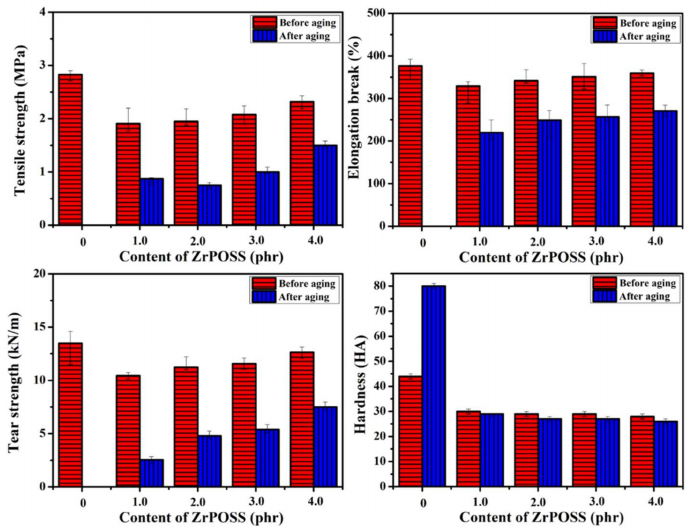
Figure 6. Mechanical properties of the SR/Zr-POSS nanocomposites before and after thermal-oxidative